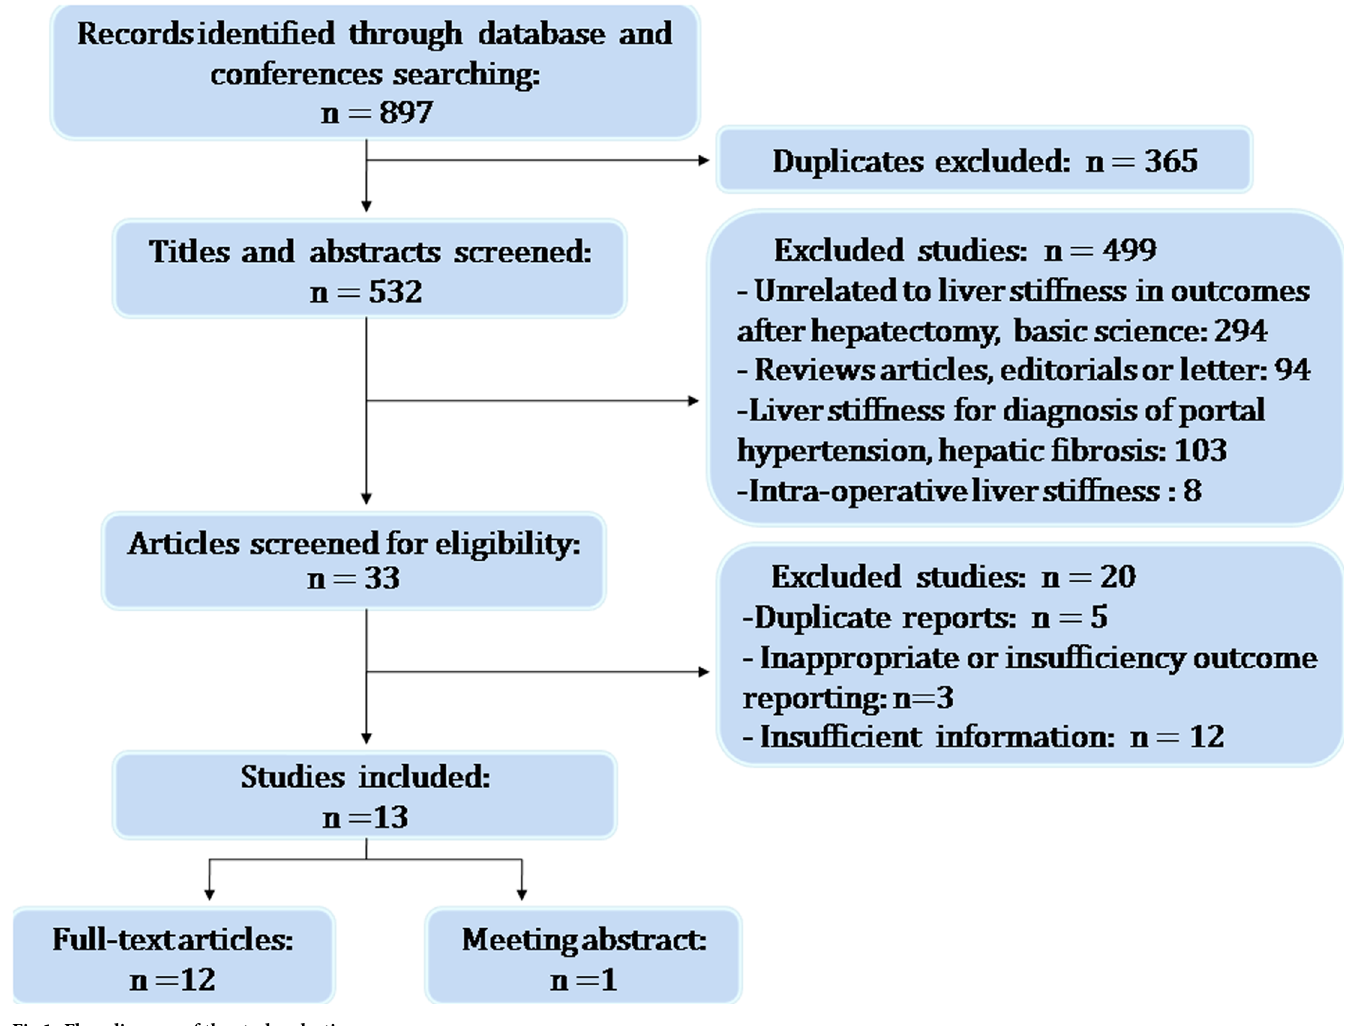
Fig 1. Flow diagram of the study selection process.